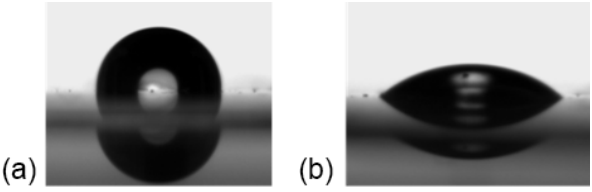
Figure 6. Contact angle measurements with water on (a) pary- lene C, θ = 90.0 ◦ ; (b) parylene C/amphiphilic block copolymer, θ = 44.3 ◦